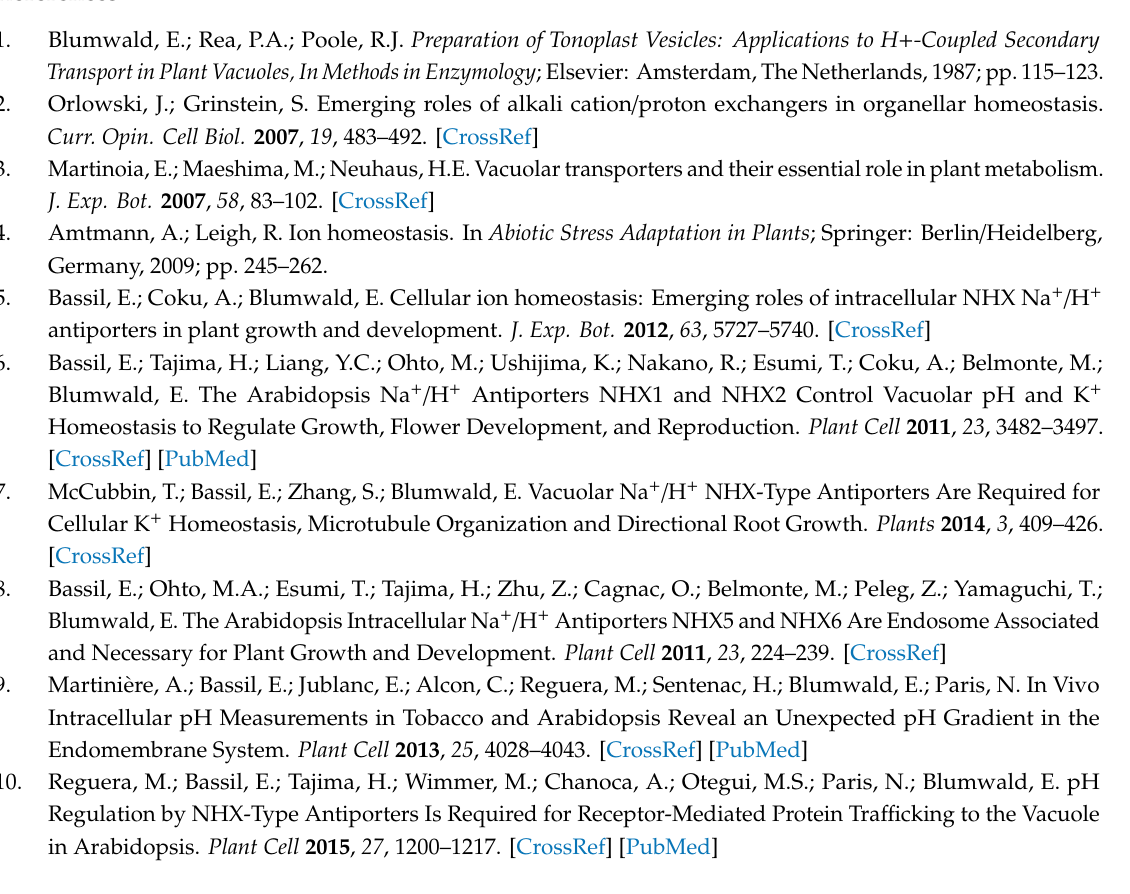
Figure S1: Root response to gravistimulation of nhx1nhx2nhx3nhx4 mutant, Figure S2: The expression level of PIN1 and PIN2 genes in WT and nhx1nhx2nhx3nhx4 mutant roots, Figure S3: Alternate method (linear